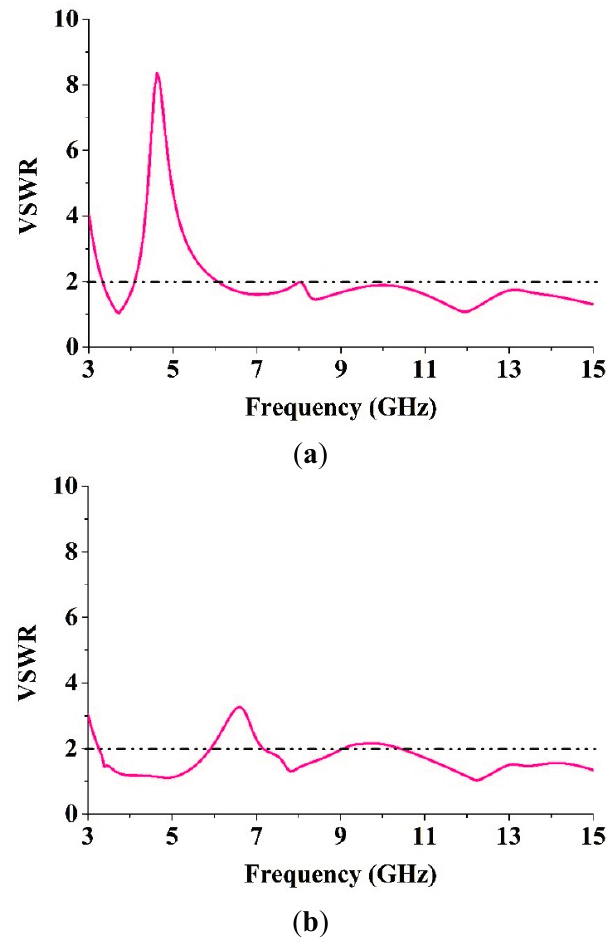
Figure 7. The VSWR of the MTM antenna ( a ) One element; ( b ) Four